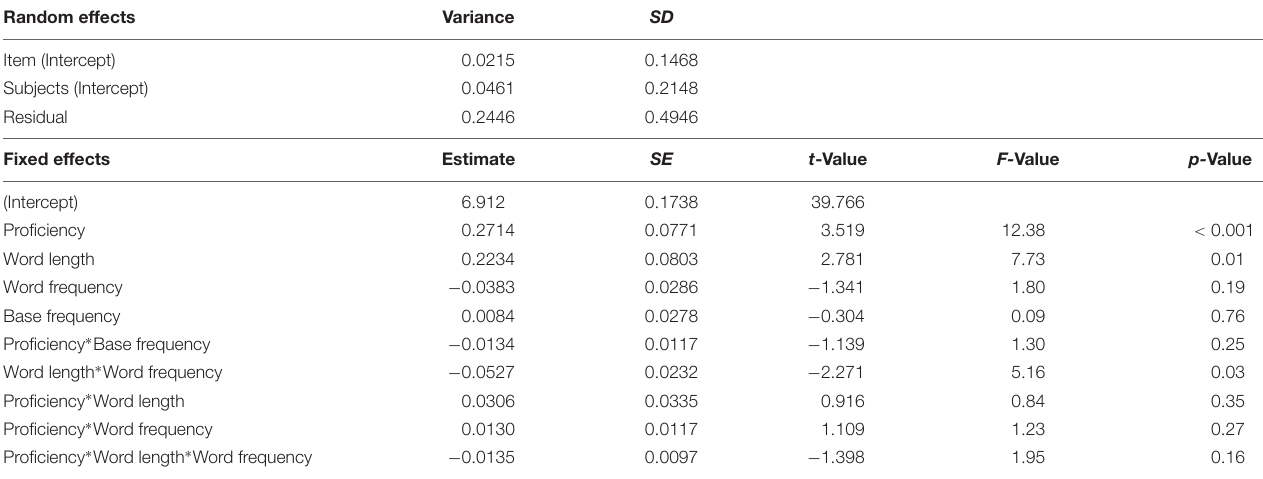
TABLE 6 | Words derived from verb base: mixed-effects on gaze duration. Random